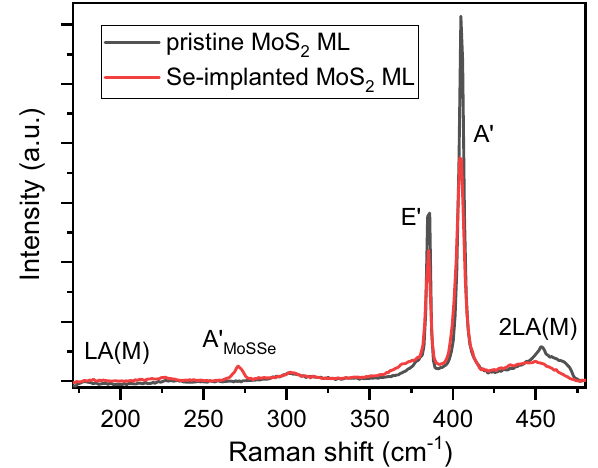
Fig. 4 Room temperature Raman spectra of mechanically exfo- liated MoS 2 ML before and after implantation. The implantation conditions were with 80 Se + at 20 eV at the fl uence of 0.8 · 10 14 cm − 2 . The spectra were acquired with a 532 nm laser excitation. Lines in the spectra are labeled with the vibrational modes that they originate from. E ′ and A ′ are vibrational modes of MoS 2